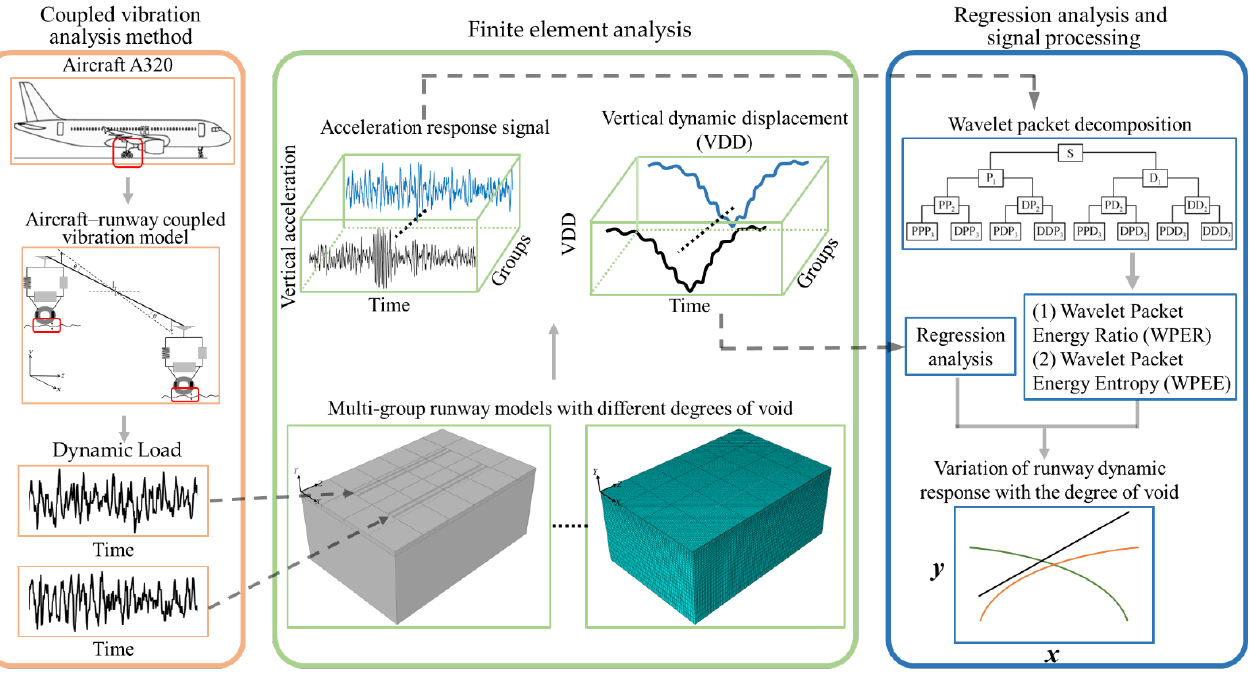
Figure 1. Research methods and steps .